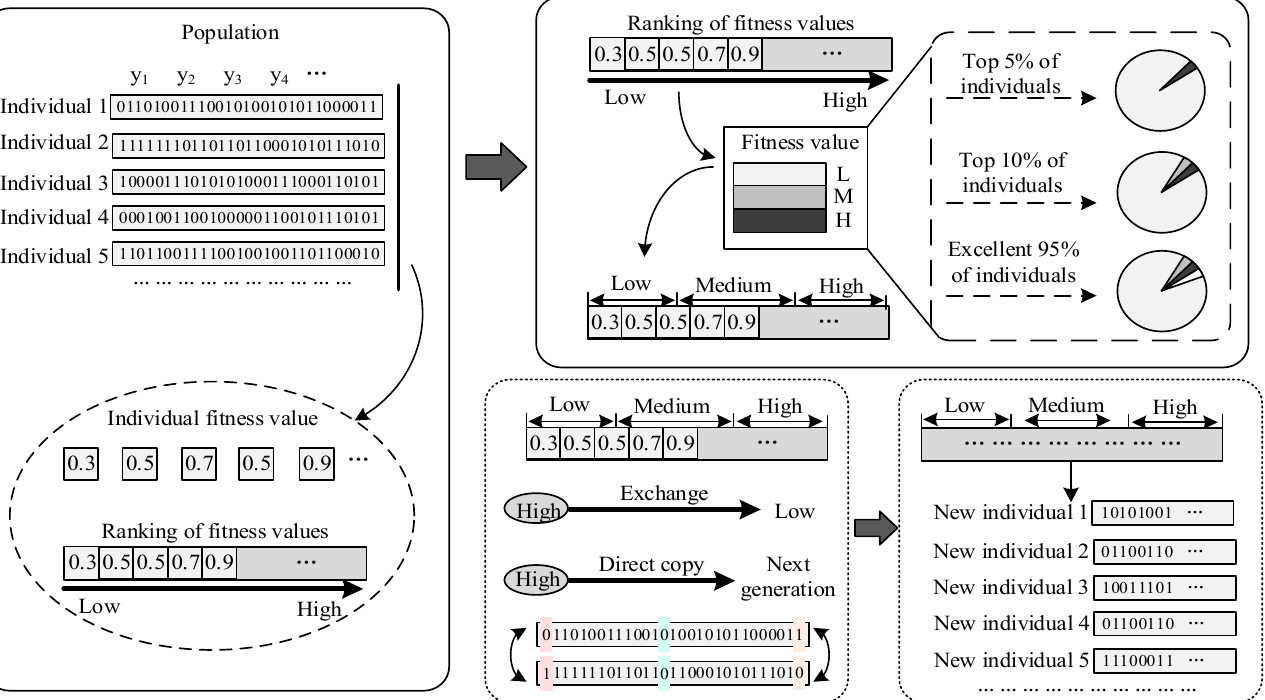
Figure 1. The proposed improved genetic algorithm.